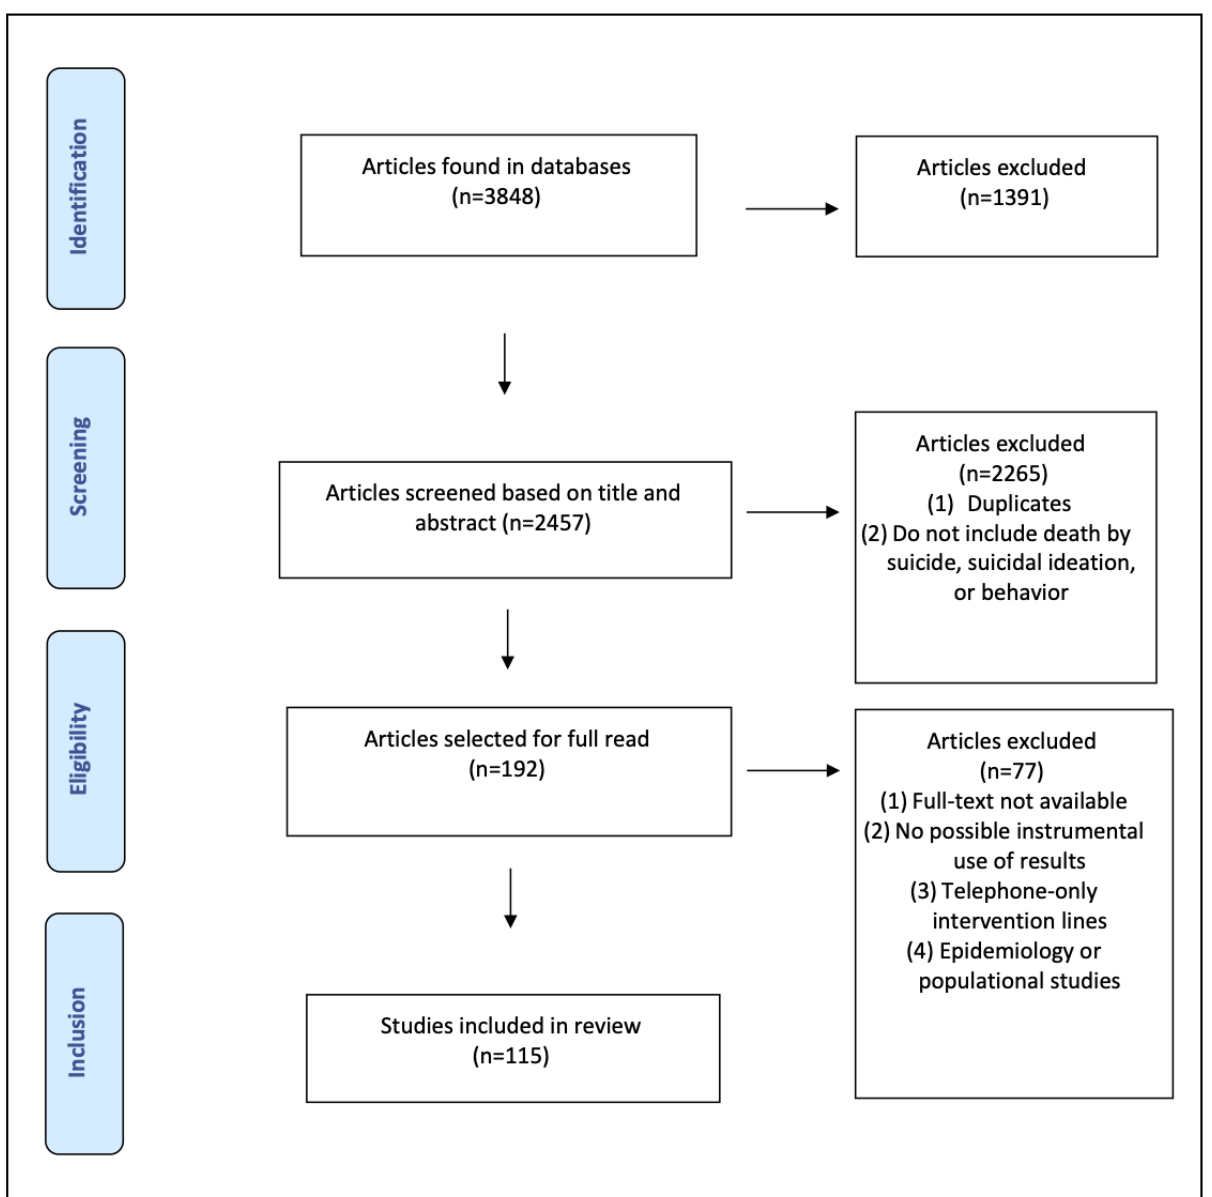
Figure 1. PRISMA (Preferred Reporting Items for Systematic Reviews and Meta-Analyses) flow